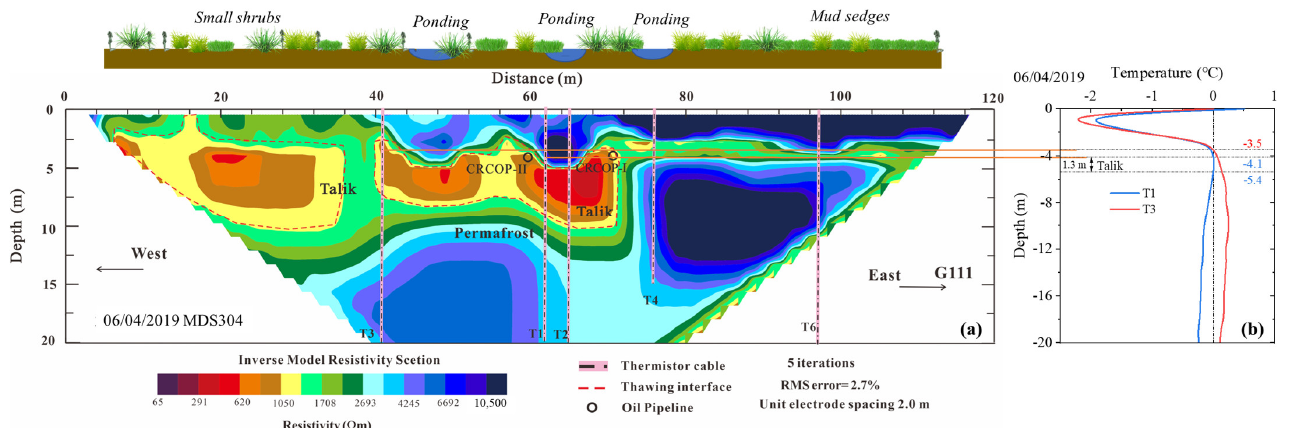
Figure 10. On 6 April 2019, an inversion profile of the ERT test results with an RMS error of 2.7% was obtained at the MDS304 site (Profile 1) ( a ), and the curve of ground temperature with a depth of borehole T1 and T3 ( b ). Note: T1,…, T6 is a ground temperature borehole; CRCOP-I: the CRCOP’s first line; CRCOP-II: the CRCOP’s second line.